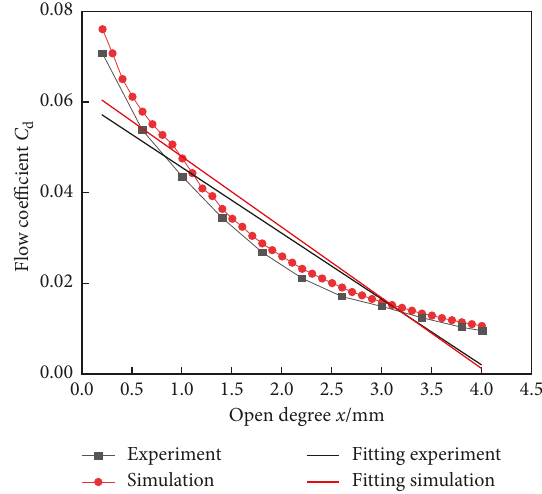
Figure 9: Flow coefficient of mixed curve.